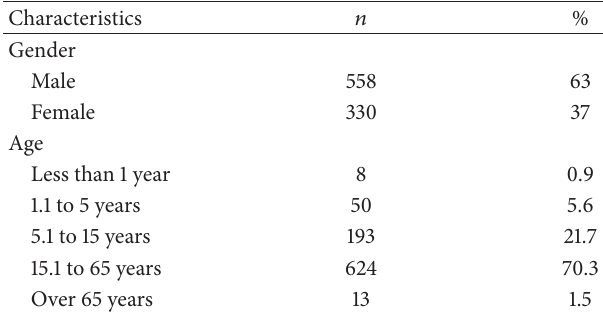
Adapted from [28]. Table 2: Demographic characteristics of 888 malaria patients from